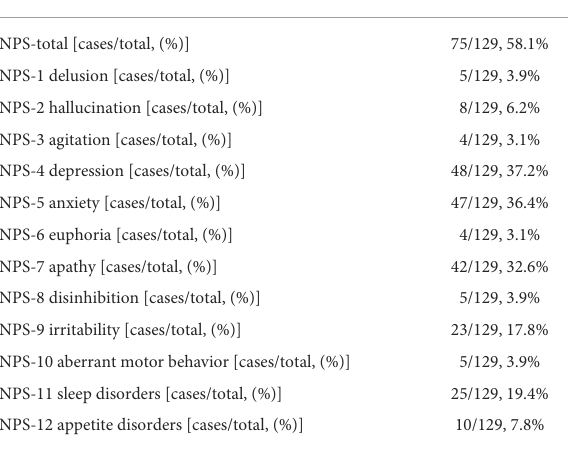
TABLE 1 Frequency of each NPS in patients with